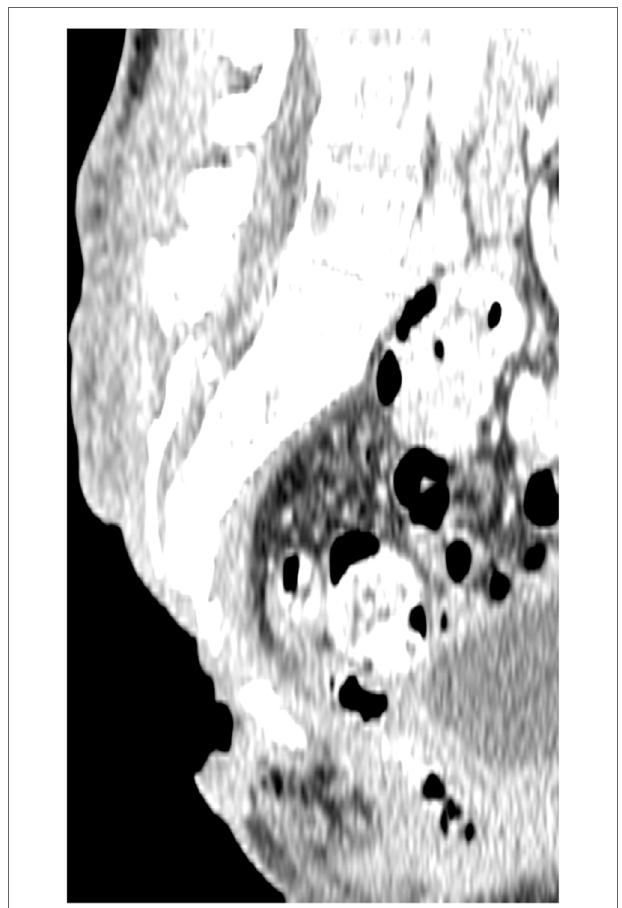
FigUre 1 | Preoperative computed tomography scan, showing the three-dimensional nature of a sacral defect